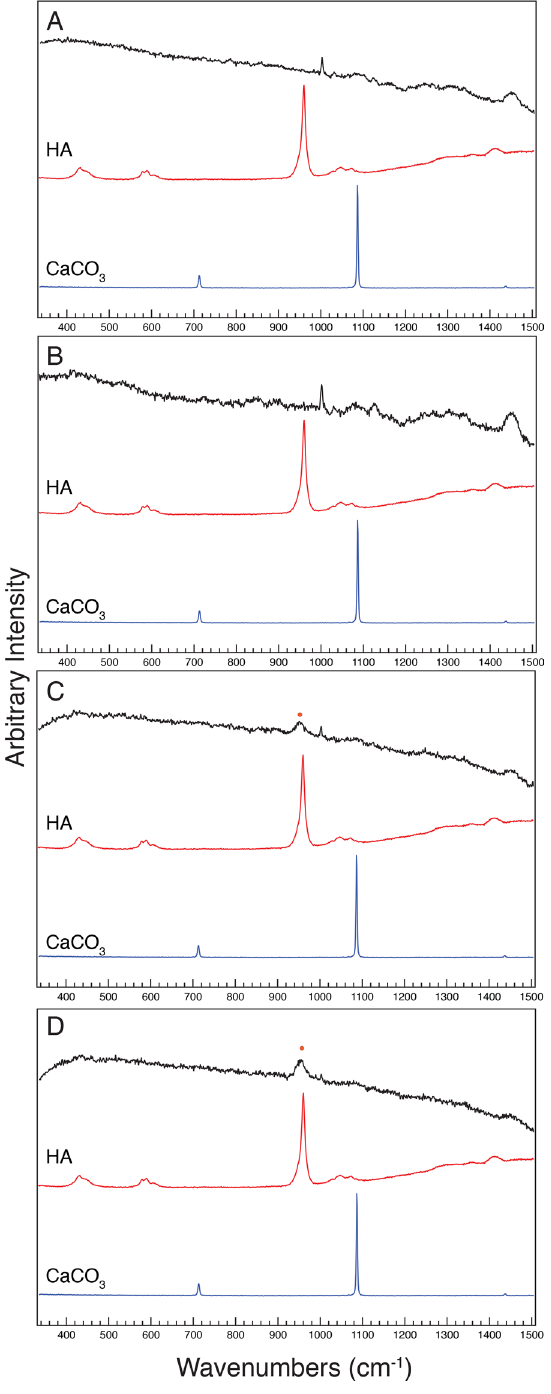
Figure 3. Raman spectra taken from the center of the surface of colonies of ( A ) P. putida KT2440, ( B ) P. syringae pv. morsprunorum 5795, ( C ) P. syringae pv. tomato DC3000, and ( D ) P. fluorescens Pf0-1, at six days of growth are colored black in each panel. A control for hydroxyapatite is labelled “HA” and is colored red and a control for calcium carbonate is labelled “CaCO 3 ” and is colored blue. A broad peak slightly downshifted from 960 cm − 1 is labelled with an orange dot and signifies the presence of amorphous calcium phosphate on the surface of cells. Bands commonly associated with biological organisms, including a peak for DNA (782 cm − 1 ) and phenylalanine (1004 cm − 1 ) and broad bands associated with amides (1230–1300 cm − 1 ) and methyl groups (1430–1460 cm − 1 ) can be seen on these spectra as well. This assay was performed three separate times and the spectra are representative of the assays. The y-axis is in arbitrary intensity units and the x-axis is in wavenumbers (cm − 1